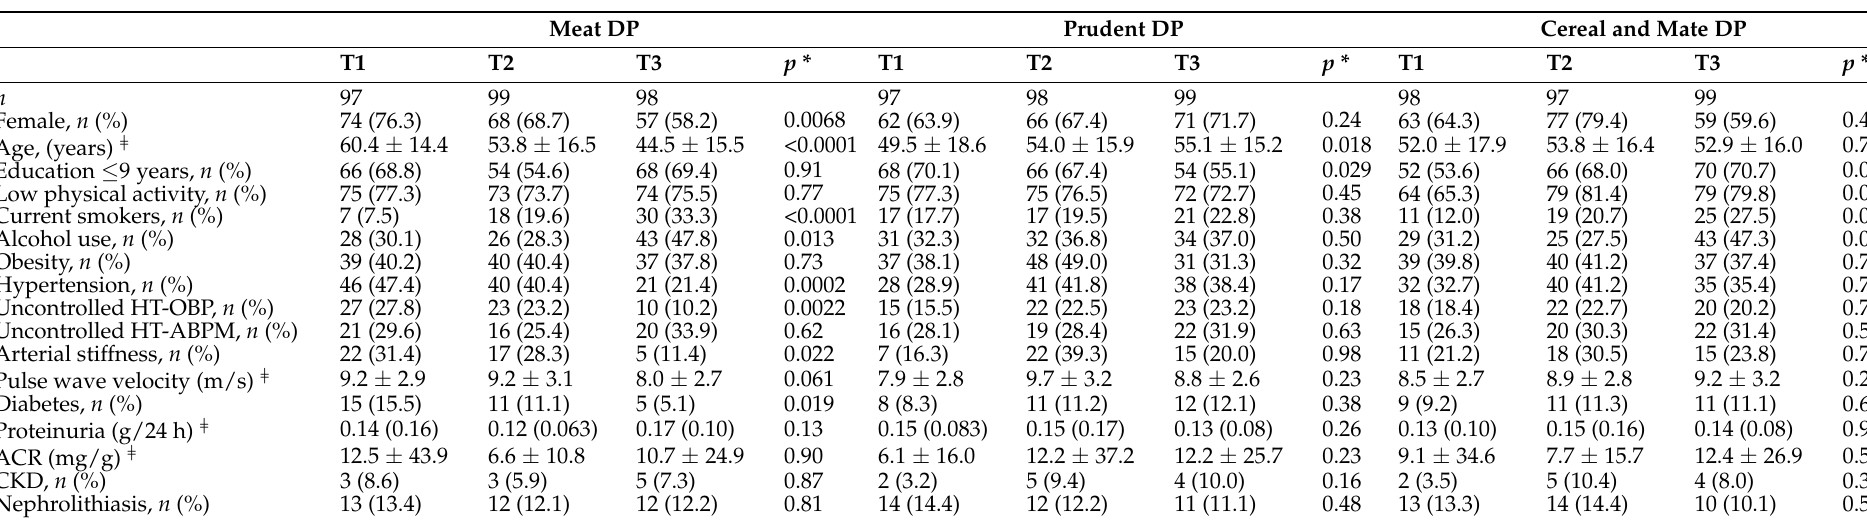
Table 3. Demographic and anthropometric characteristics, conventional risk factors, and cardiovascular and renal phenotypes by tertiles (T) of dietary patterns in Uruguayan